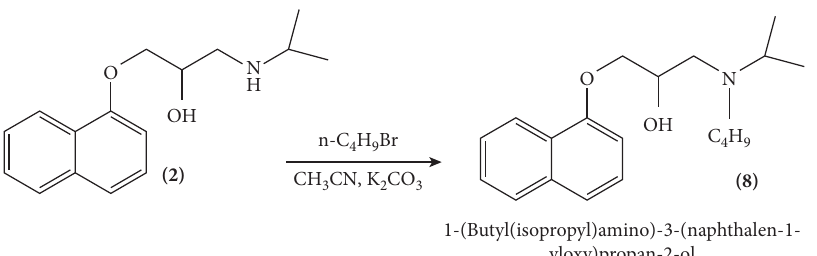
Figure 6: The scheme describes the synthesis of propranolol with n-butyl bromide (compound 8 ) at conditions of CH